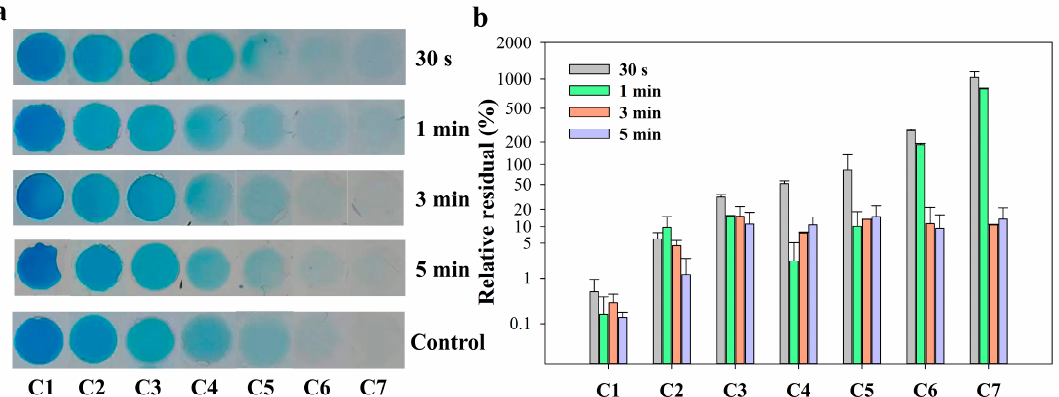
Figure 3. ( a ) Photos of gradient concentration array of blue ink solution in seven microchambers with different mixing time and control group performed in tube; ( b ) The relative residual of saturation of the microchambers area in the photos.